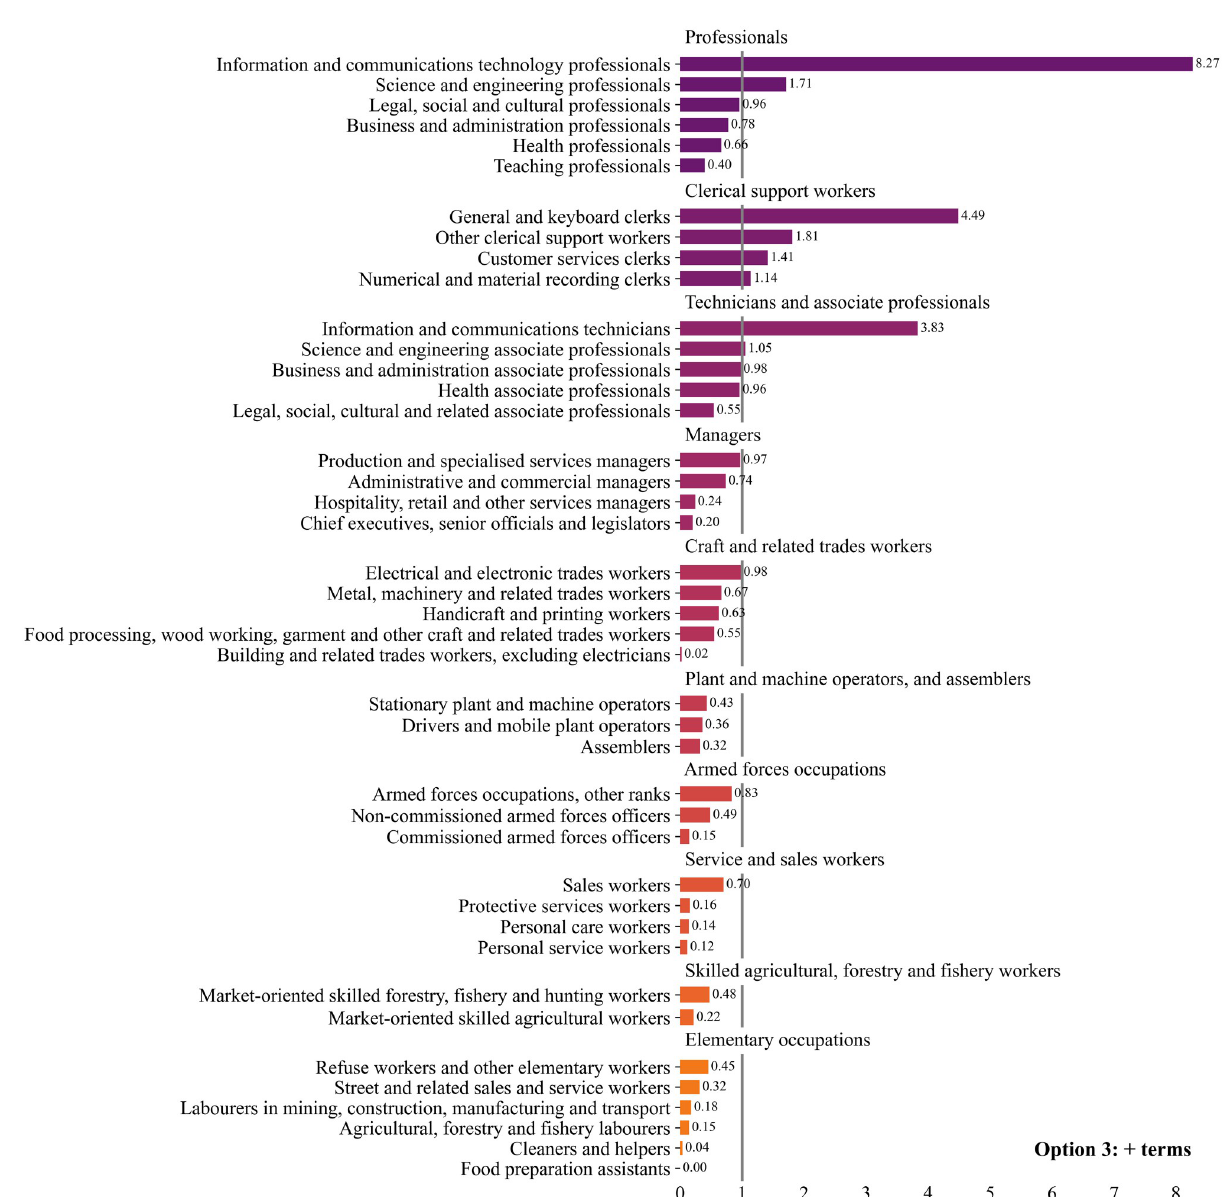
Fig 4. Mean values of DCI by 2-digit ISCO code. Note 1: we have added a line at value one in order to visually distinguish occupation groups with a revealed comparative advantage from those with a revealed comparative disadvantage. Note 2: the mean values of the DCI by major groups are as follows; Professionals (1.66), Clerical support workers (1.50), Technicians and associate professionals (1.03), Managers (0.72), Craft and related trades workers (0.57), Plant and machine operators, and assemblers (0.41), Armed forces occupations (0.37), Skilled agricultural, forestry and fishery workers (0.32), Service and sales workers (0.34), and Elementary occupations